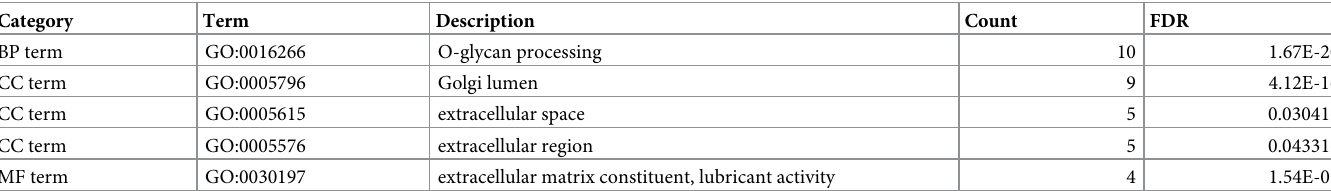
Table 4. Functional analyses of PPI network